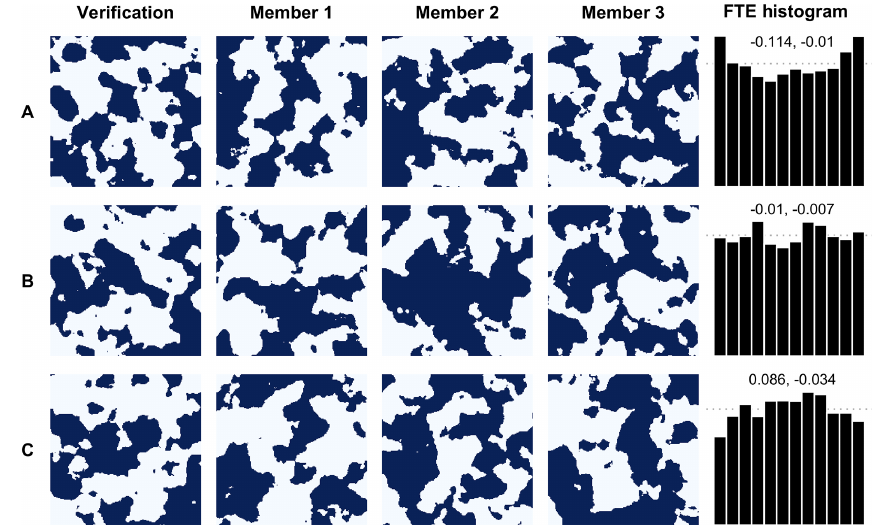
Figure D1. As Fig. 3 but ensemble fields are constructed with skill parameter ρ = ω = 0.